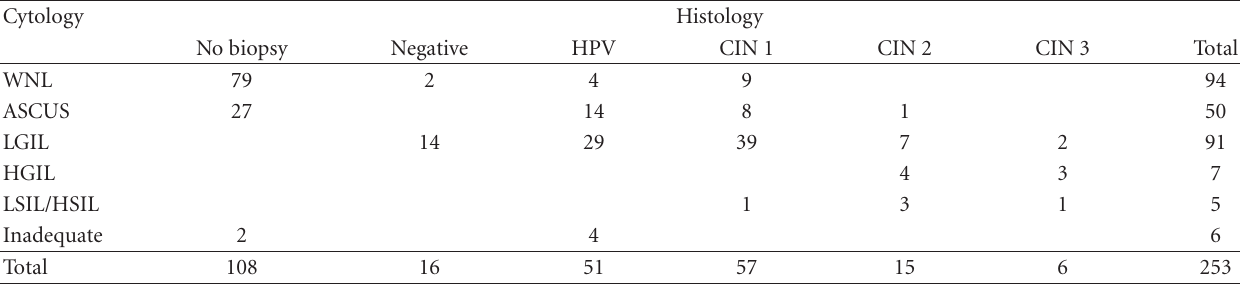
Table 6: Correlation of cytological findings to histological diagnosis.